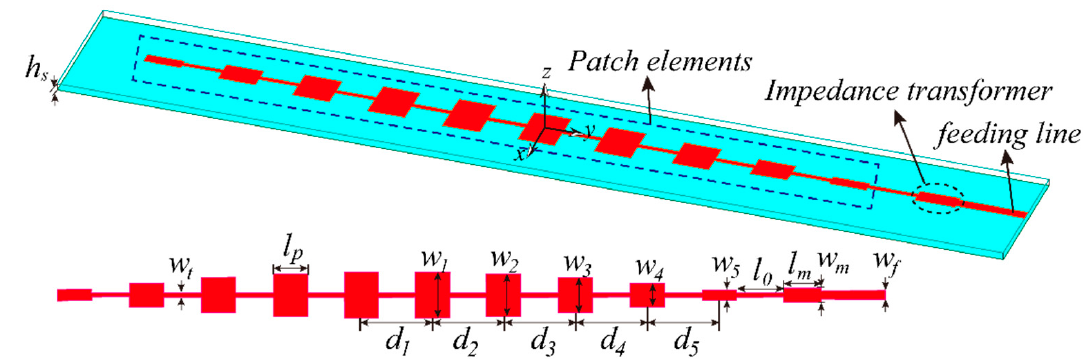
Figure 1. The geometry of the low SLL, linear series-fed patches sub-array. Table 1. The dimensions of the optimized series-fed patch antenna array. (Unit: mm).